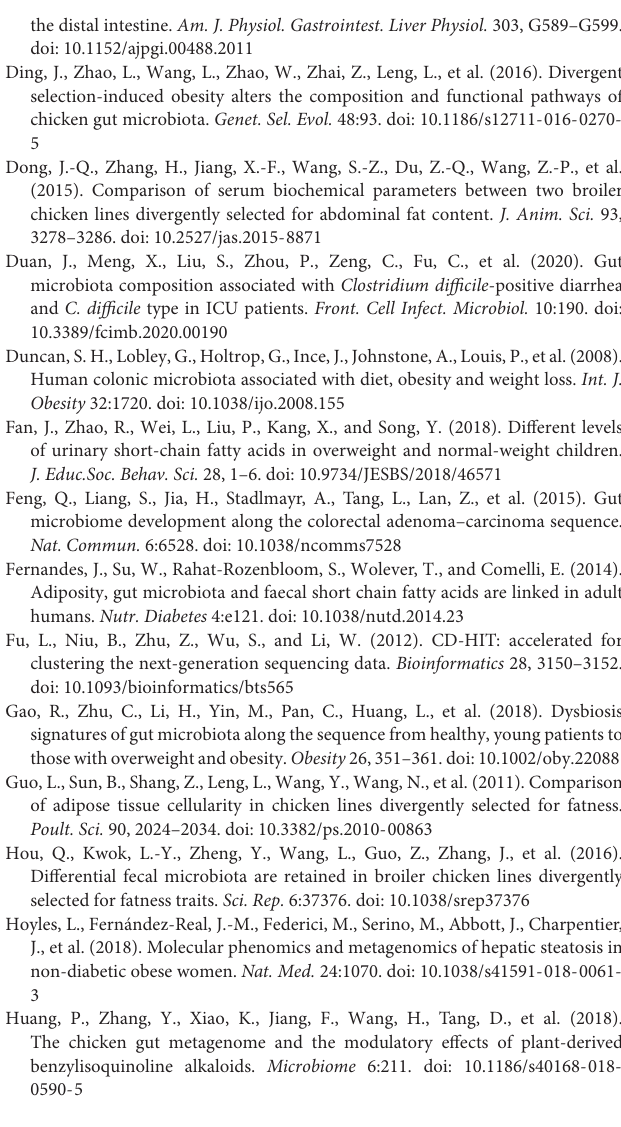
Supplementary Table 6 | The basic statistics of mRNA-Seq data. Supplementary Table 7 | The DEG significantly enriched in lipid metabolism relevant